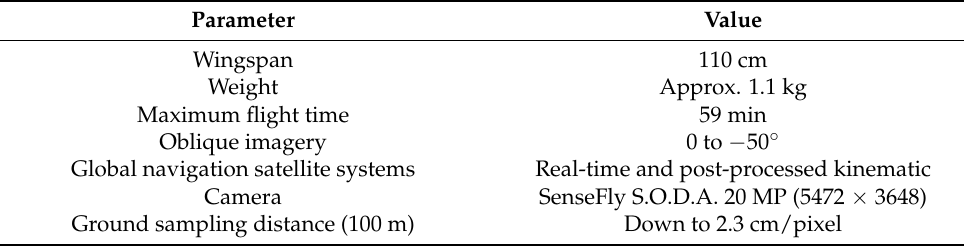
Table 1. SenseFly eBee Plus